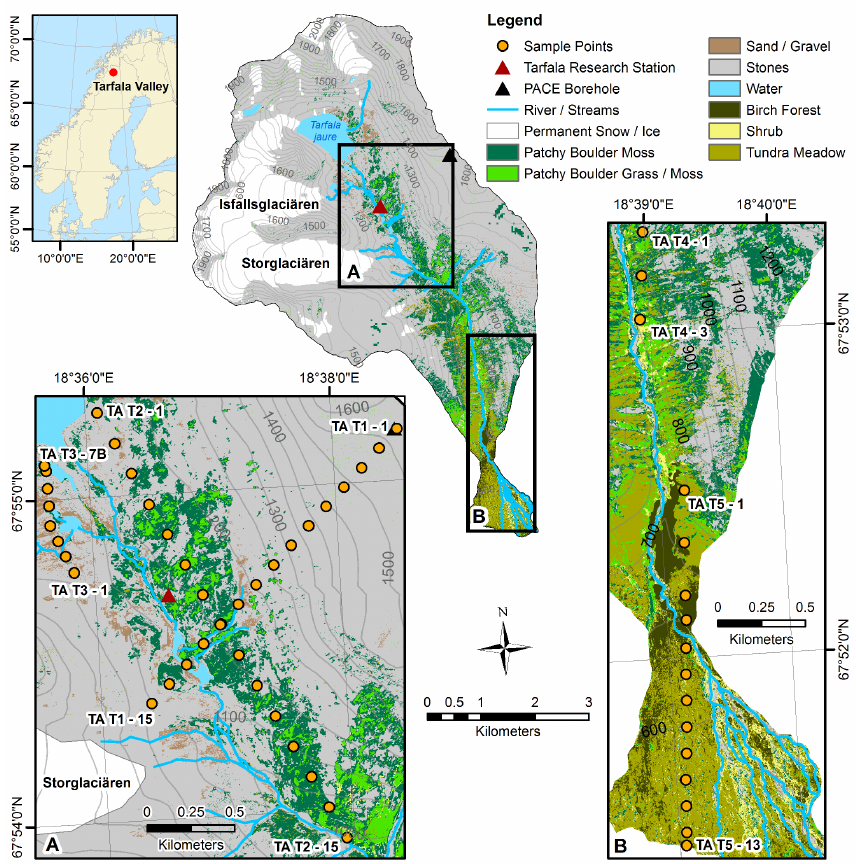
Figure 1. The Tarfala Valley study area, including an overview location map, a map of the whole study area with land cover classification and detailed maps showing transect and sample point locations in the central (a) and lower (b) parts of the